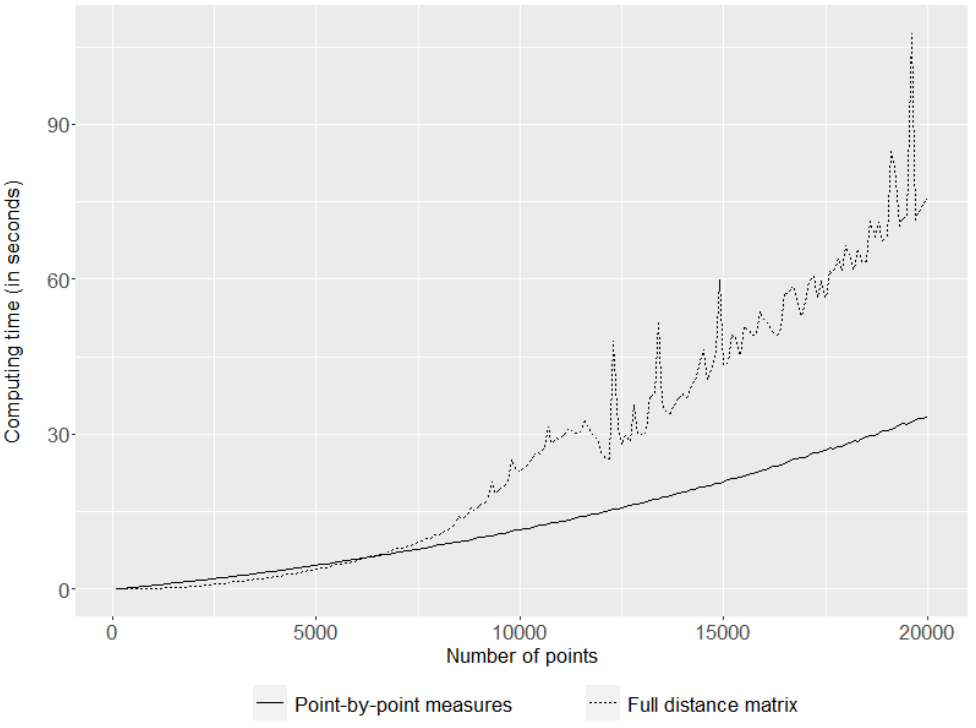
Figure 2. Changes in computation time according to the number of points.